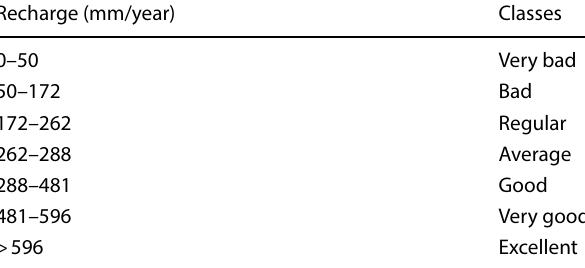
Table 2 Aquifer recharge classification